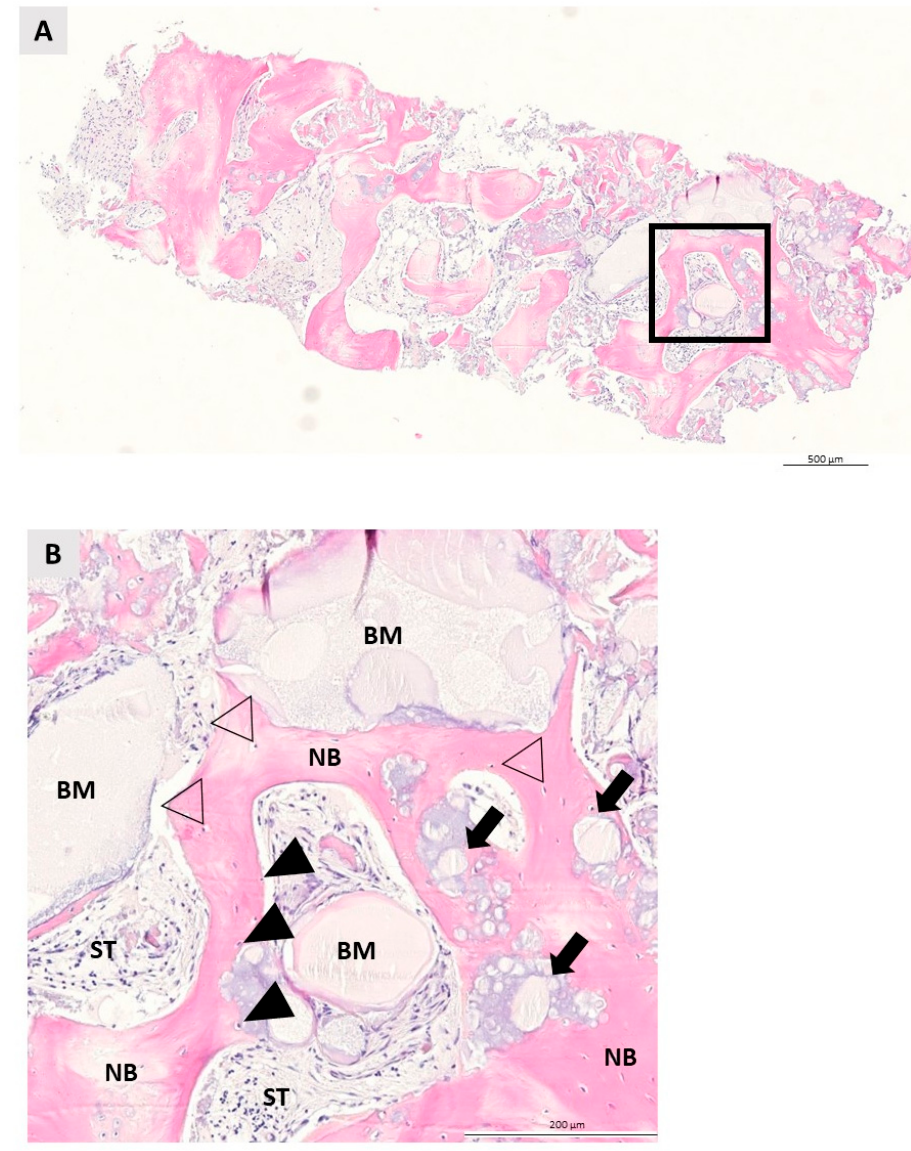
Figure 4. Representative specimen of a bone biopsy taken six months after augmentation with maxresorb ® inject. ( A ) Longitudinal section through the specimen showing the new bone for- mation and the IBCP granules integrated into it. The square marks the area of interest in the figure below (hematoxylin-eosin, 10 × magnification). ( B ) Details of the area of interest. The IBCP (biomaterial = BM) is in direct contact with newly formed bone (NB) and soft tissue (ST). Formation of NB begins at the boundary between the IBCP and the defect. The cells in the calcified bone matrix are osteocytes (no filling triangles), whereas osteoblasts (black filling triangles), their precursor, were detected at the boundary between IBCP and NB. Note the remaining IBCP granules (black filling triangles) integrated into the NB. No inflammatory tissue reaction was observed (hematoxylin-eosin, 20 ×